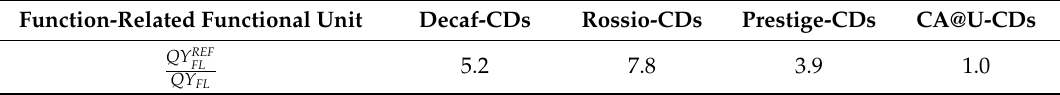
Table 2. Function-related functional unit for decaf-CDs, rossio-CDs, prestige-CDs and CA@U-CDs.